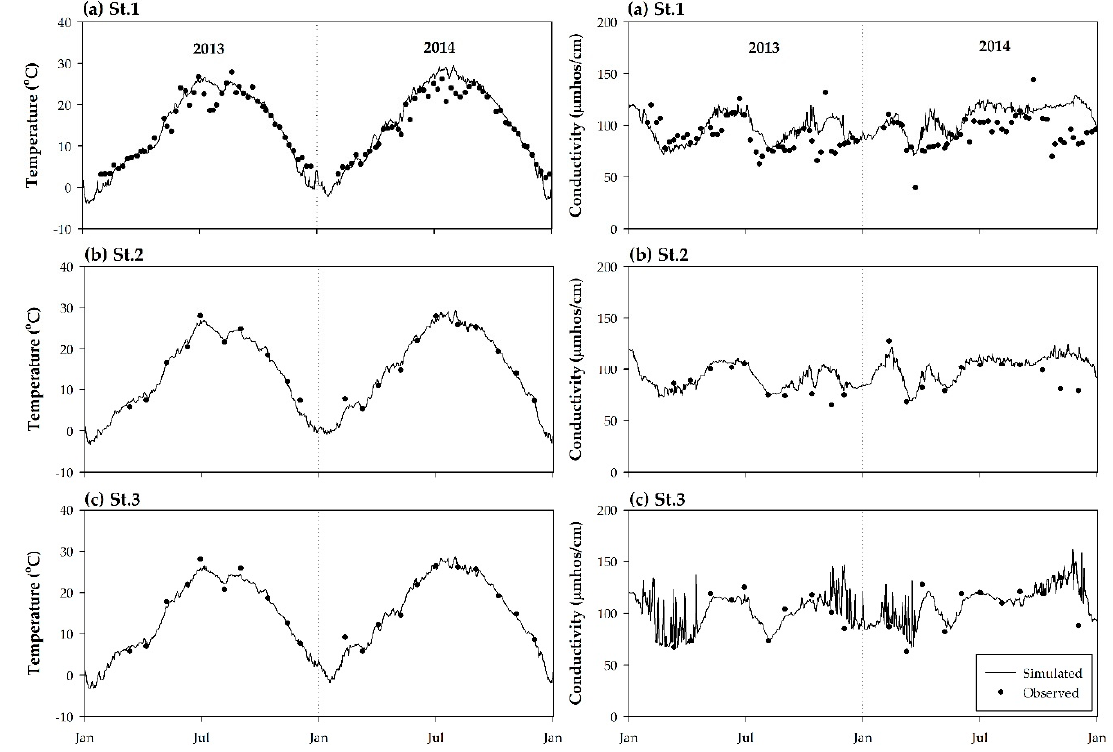
Figure 4. Comparison of observed and simulated temperature and conductivity for calibration (2013) and verification (2014) at ( a ) St.1, ( b ) St.2, and ( c ) St.3.